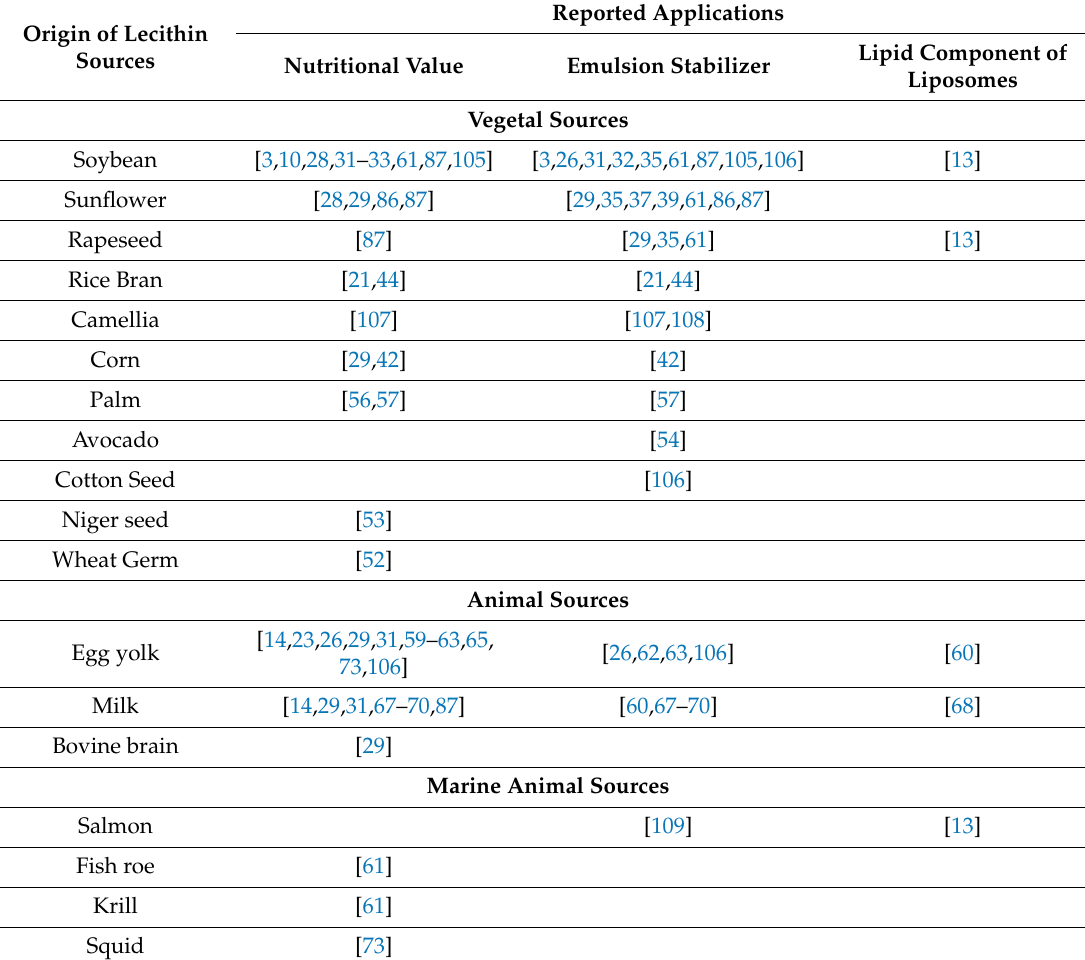
Table 4. Uses and applications of lecithins derived from vegetable, animal, and marine animal